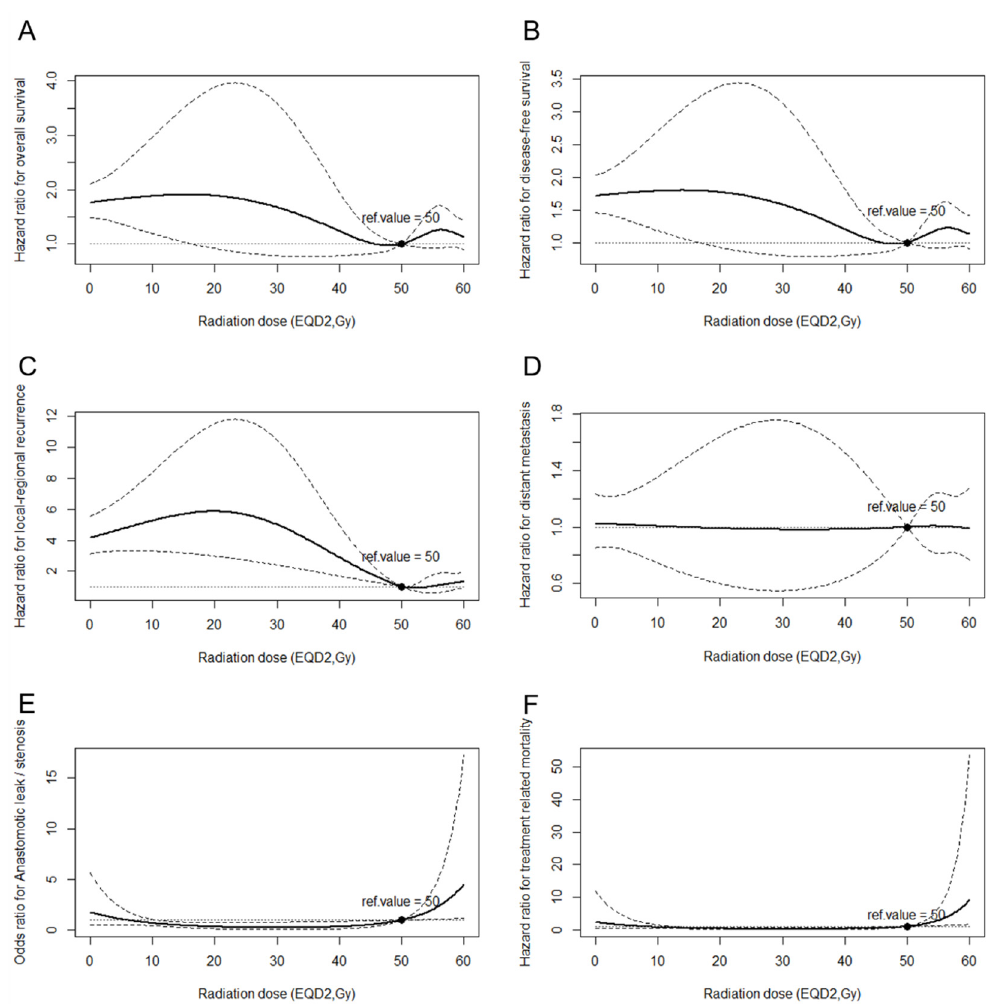
Figure 2. Relationship between adjuvant radiation dose and OS ( A ), DFS ( B ), LRFS ( C ), DM ( D ), anastomotic stenosis/leak ( E ), and TRM ( F ) as analyzed using the restricted cubic spline regression model for 2765 patients with T1-2N1-3 or T3-4N0–3 lesions and available for the analysis of the effect of aRTD.